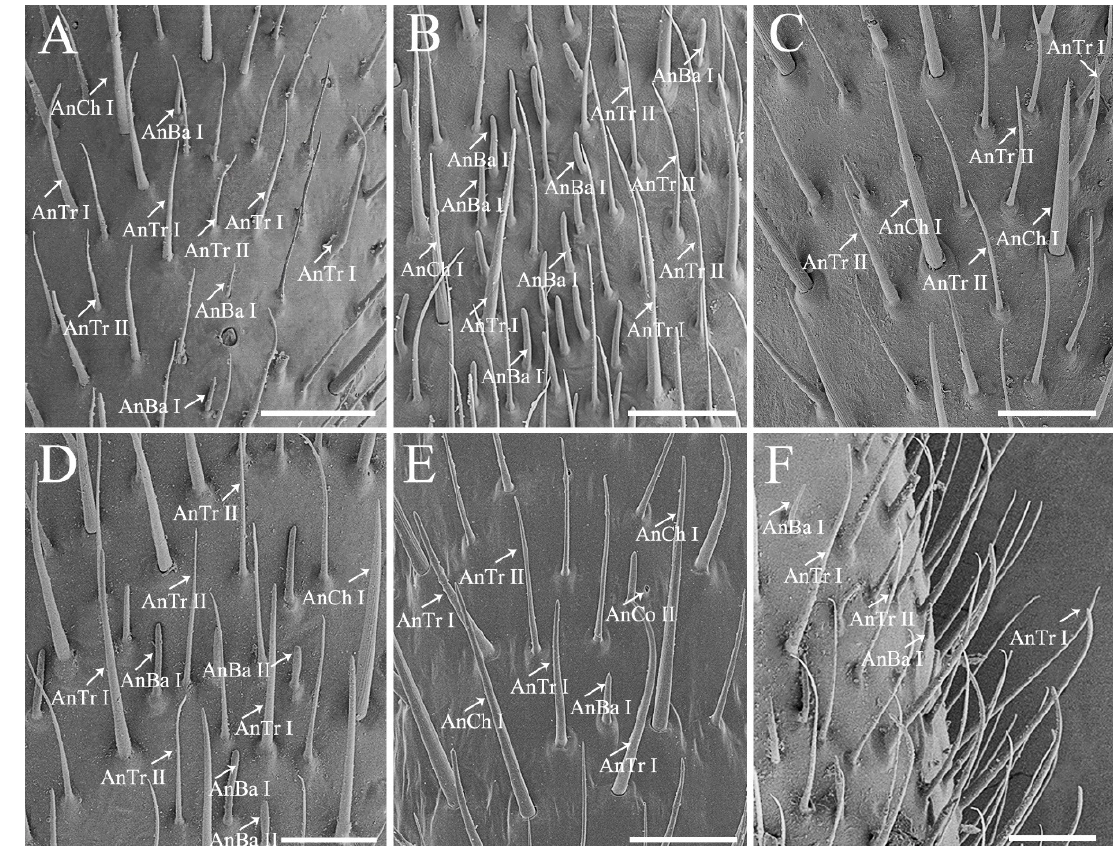
Figure 2. Dorsal view of the antennal distiflagellomere of the six pentatomid species, showing the distribution of antennal sensilla chaetica, sensilla trichodea, and sensilla basiconica. ( A ) Cressona divaricata , ( B ) Eocanthecona furcellata , ( C ) Eurydema dominulus , ( D ) Halyomorpha halys , ( E ) Plautia crossota , and ( F ) Scotinophara lurida . Scale bars: ( A ) 50 µ m; ( B – F ) 25 µ m. Abbreviations: AnBa I–II, antennal sensilla basiconica I–II; AnCh I, antennal sensilla chaetica I; AnTr I–II, antennal sensilla trichodea